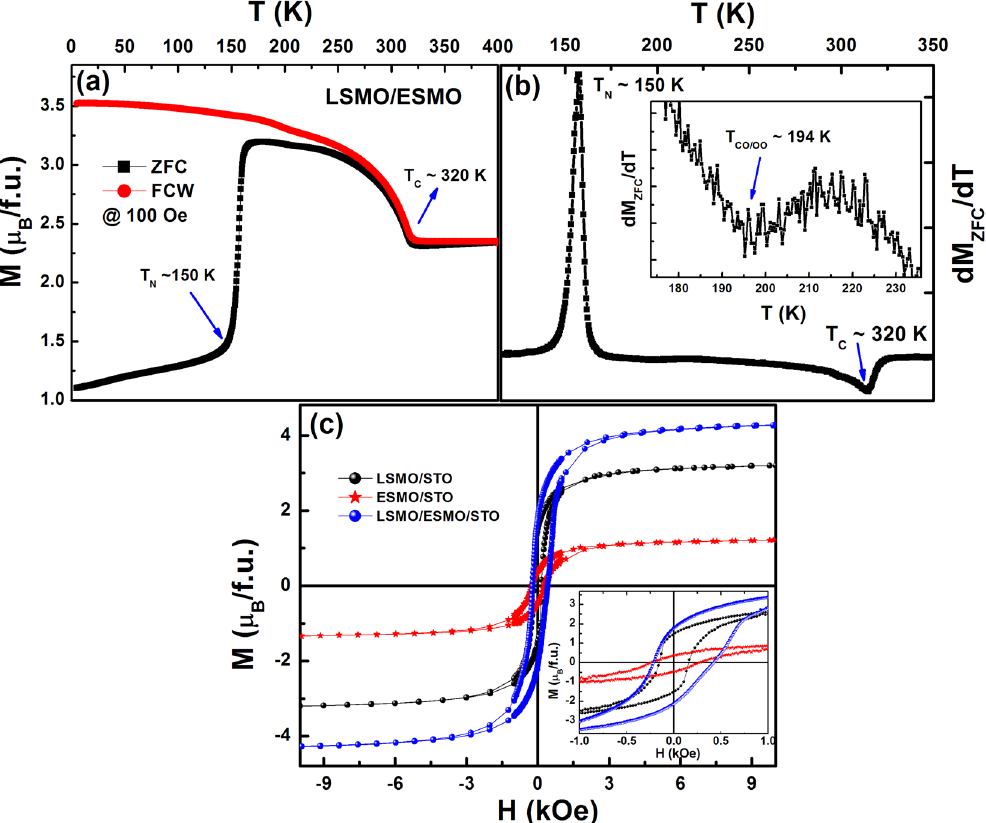
Figure 3. ( a ) M vs T (K) data for the LSMO/ESMO bilayer in the ZFC and FC protocols, ( b ) first derivative of ZFC-M with respect to T (K), to represents the various magnetic transitions, and its inset is the magnified view of the dM ZFC /dT vs. T (K) to show the charge order/orbital ordering at ~194 K. ( c ) Isothermal M(H) curves at 5 K for the single reference layers and bilayer (inset is the enlarged view of M vs. H at lower